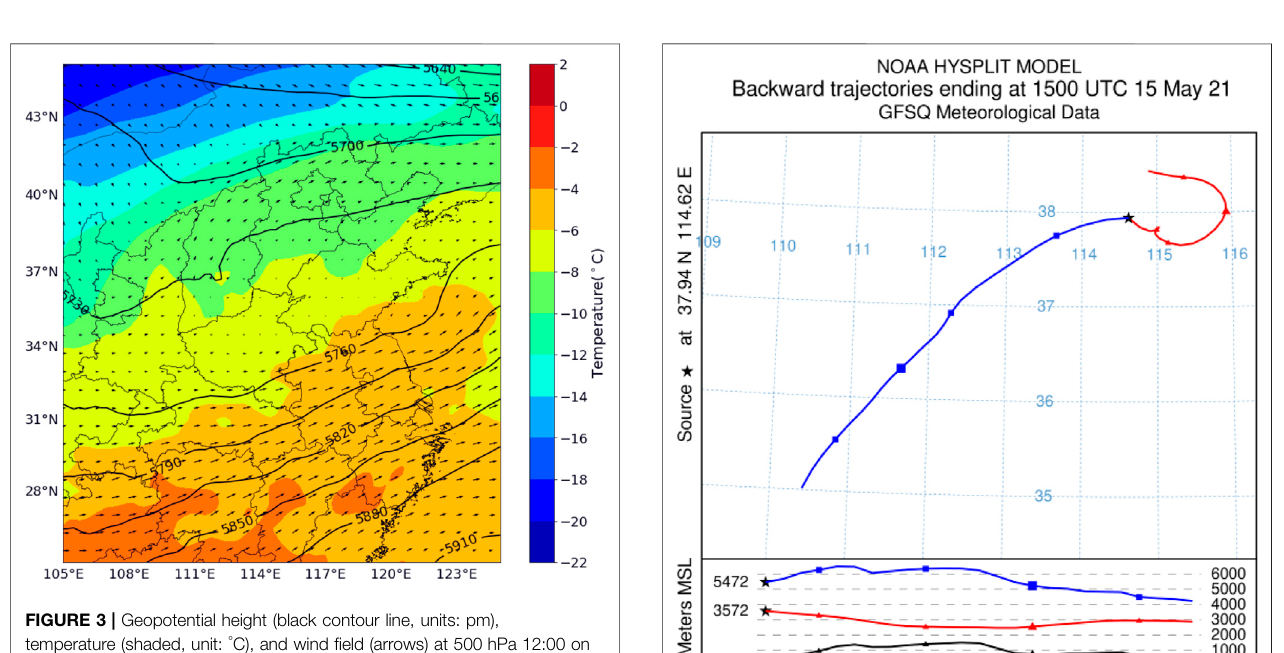
FIGURE 2 | The temporal variation of relative humidity (contour), temperature (dotted line), and wind on May 15, 2021 in Luancheng District of Shijiazhuang.